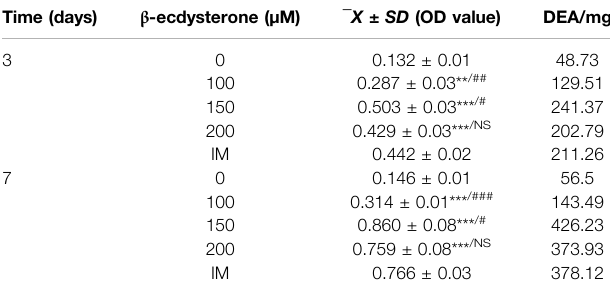
Values are expressed as means X ± SD ( n = 6). The “ * ” stands for the control group (0 μ M), which was compared with each experimentalgroup. p < 0.05, **p < 0.01, ***p < 0.001. The “ # ” stands for the IM group, which was compared with each experimental group. # p < 0.05, ## p < 0.01, ### p < 0.001. ALP, alkaline phosphatase activity; DEA, diethanolamine enzyme activity